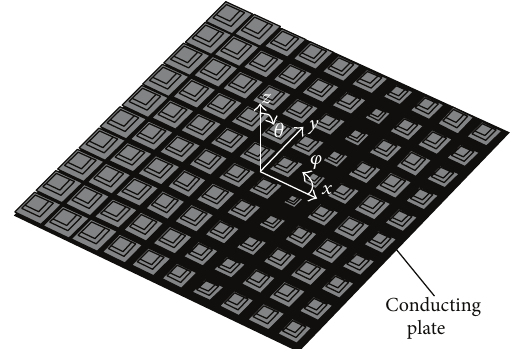
Figure 4: Nonuniform surface consisting of three layers of square patches with variable size above a conducting ground. All the substrate layers are set transparent so that the ground layer and the bottom and middle patch layers could be shown.